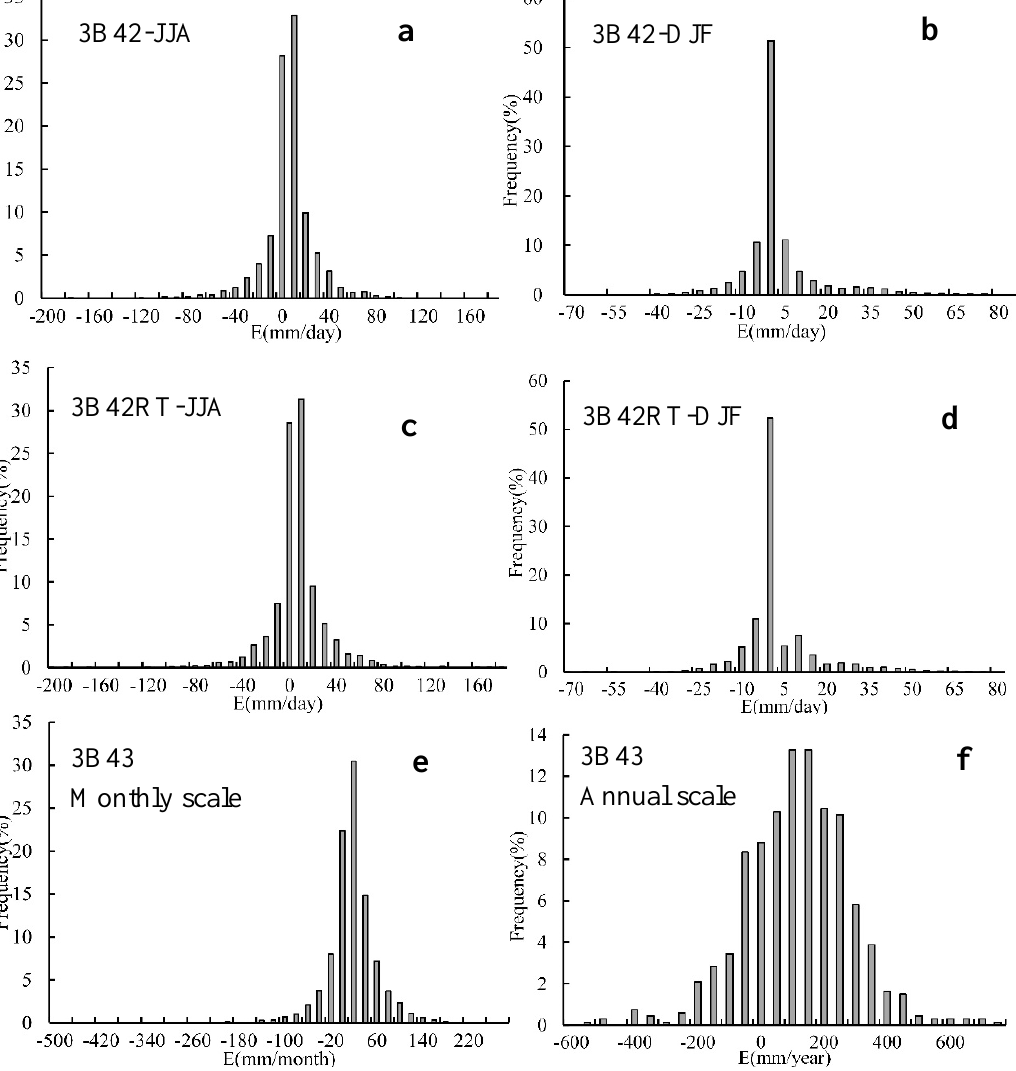
Figure 9. The distribution of histogram of E, with ( a , c ) for TRMM 3B42; ( b , d ) for TRMM 3B42RT; ( e , f ) for TRMM 3B43.